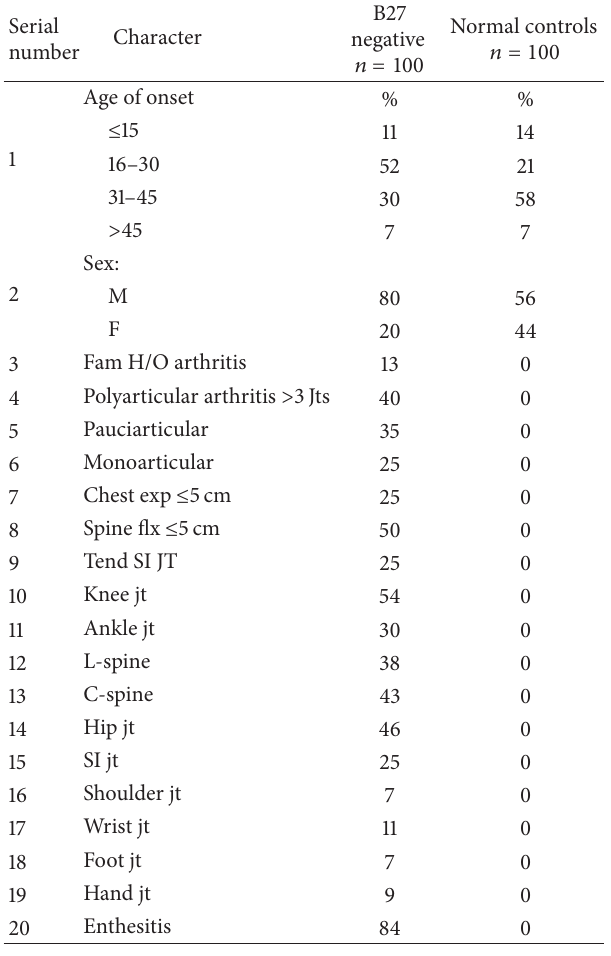
Table 2: Clinical presentation of B27 negative SpA